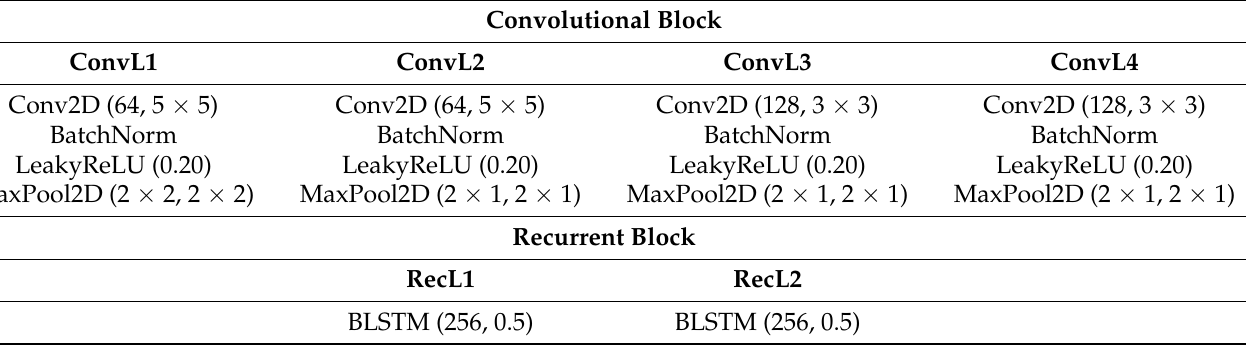
Table 2. Layer-wise description for the CRNN architecture considered. Notation: Conv ( f , w × h ) stands for a convolution layer of f filters of size w × h pixels, BatchNorm performs the normalization of the batch, LeakyReLU ( α ) represents a leaky rectified linear unit activation with negative slope value of α , MaxPool 2 D ( w × h , a × b ) stands for the max-pooling operator of dimensions w × h pixels with a × b striding factor, and BLSTM ( n , d ) denotes a bidirectional long short-term memory unit with n neurons and d dropout value